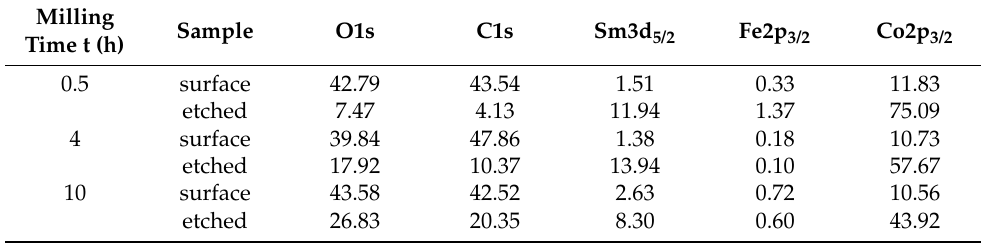
Figure 8. ( a ) Survey spectra; ( b ) valence bands; ( c ) Sm3d core level lines; ( d ) Co2p core level lines; and ( e ) Fe2p core level lines for as-milled SmCo 5 /α-Fe (5%wt. of α-Fe) powders. Table 3. Chemical composition in at. % determined based on survey spectra for as-milled SmCo 5 /α-Fe (5%wt. of α-Fe).